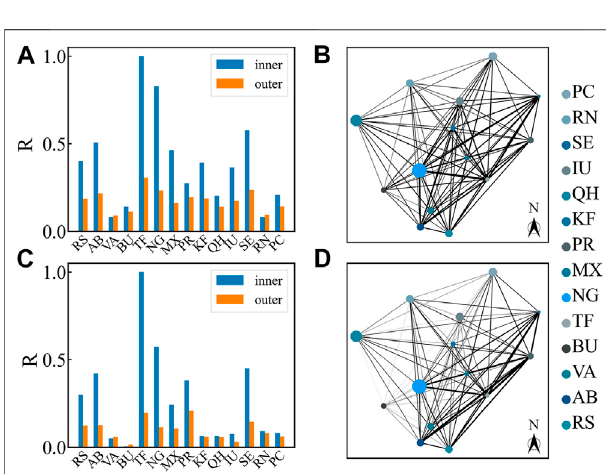
FIGURE 4 | Relative connection density and intercity alarm relevance network (CCAN): (A) Percentage of relative density inside and outside cities when using threshold 0.8. The inner relative density is painted blue and the outer is painted orange. Each R is normalized by the maximum value (0.1902) of inner relative density. (B) City-to-city network under threshold 0.8. Different cities are symbolized by dots with different colors. The size of dots represents the number of devices in every city. The width of edges is proportional to the value of relative density between cities. (C) Percentage of relativedensityinsideandoutsidecitieswhenusingthreshold0.999.Each R is normalized by the maximum value (0.0664) of inner relative density. (D) City- to-city network under threshold 0.999. (A,C) show that when increasing the thresholdofremovingedges,thestructurebetweencitiesstartsemerging(still weaker than the connection inside cities). (B,D) show that cities lying in the southeast of the province are connected more strongly than